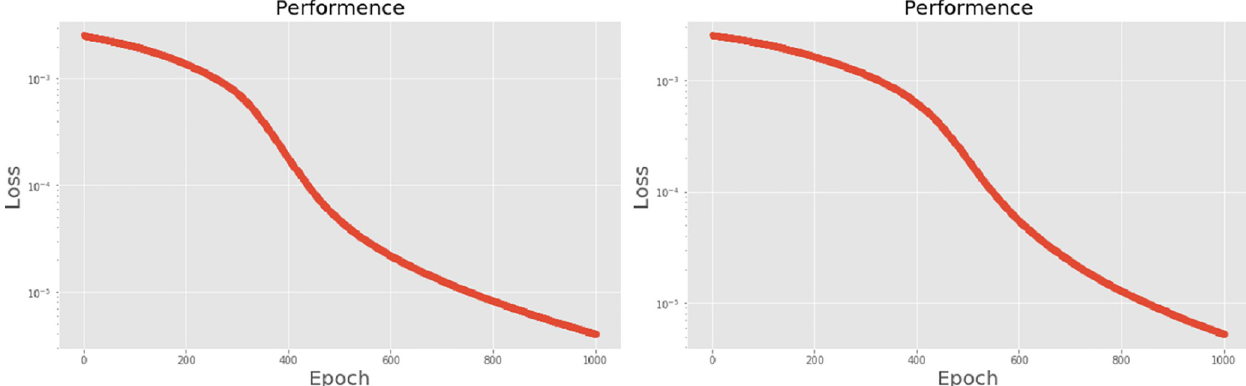
Fig 17. (a) The graph shows the performance of MFCC-DNN-12-layer model; (b) The graph shows the performance of MFCC-PCA-DNN-12-layer model.